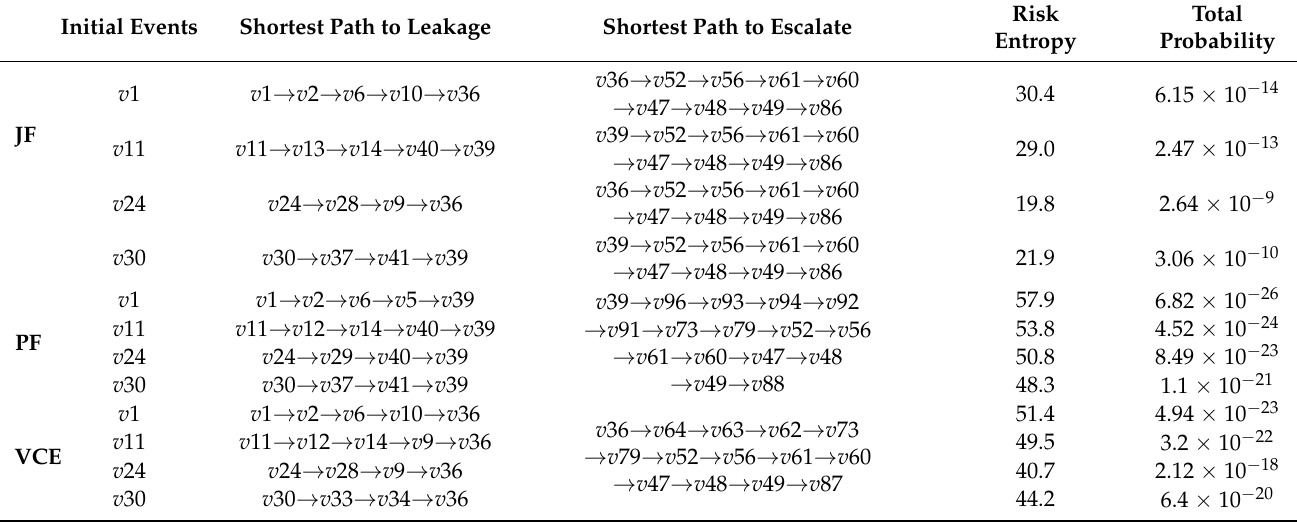
Table 7. The shortest path for the initial event to trigger JF, PF, and VCE